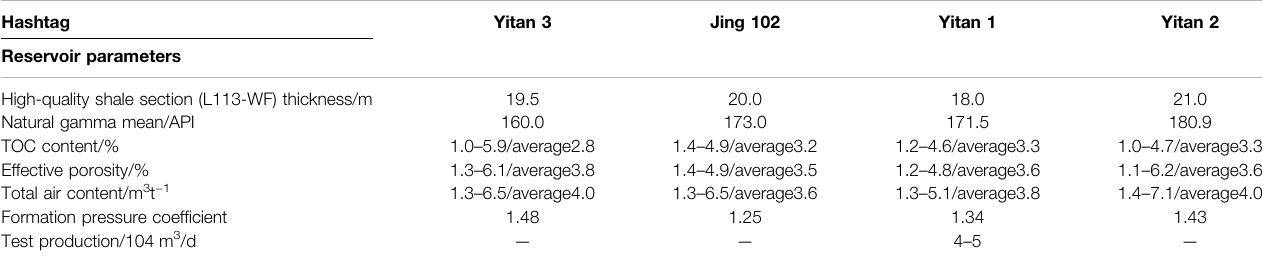
The number of fractures where the angle between the direction of the maximum horizontal principal stress and the direction of the fracture is greater than 45 °